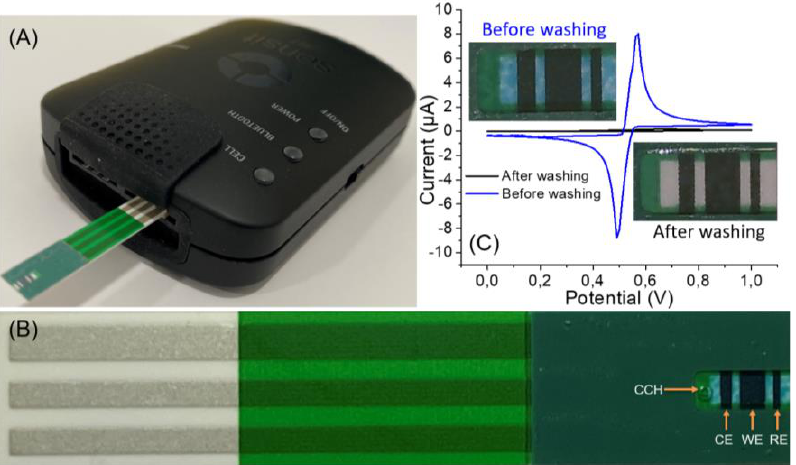
Figure 1. ( A ) Image of CTS inserted into the portable electrochemical reader. ( B ) Image of CTS with the positions of the electrodes. ( C ) CV responses of the CTS and washed CTS in PBS (pH 7.4, 10 mM) with scan rate 100 mV/s. Inset: images of the sensing zone of the unwashed and washed CTS.